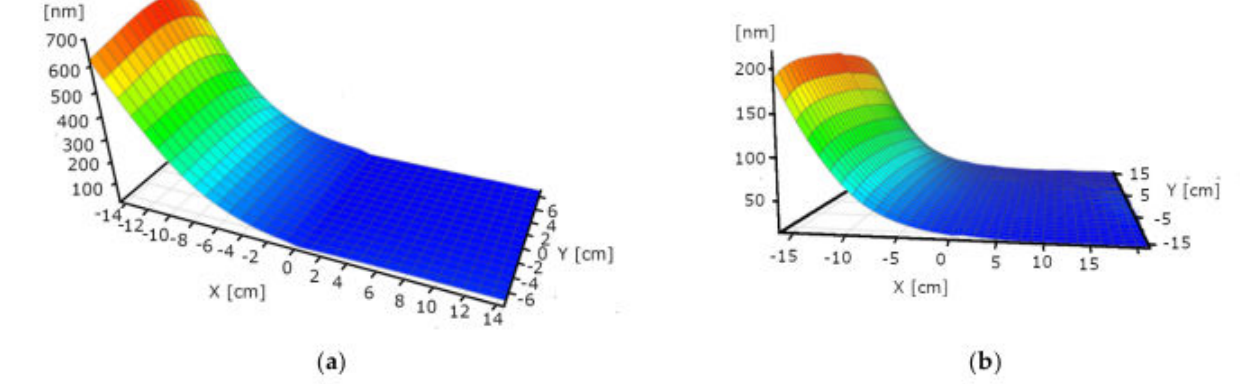
Figure 7. Thickness-maps (in nm) of “W-target only” samples at 1 ( a ) and 0.75 ( b ) kW power. Maximum thickness value is around 700 and 200 nm, respectively.